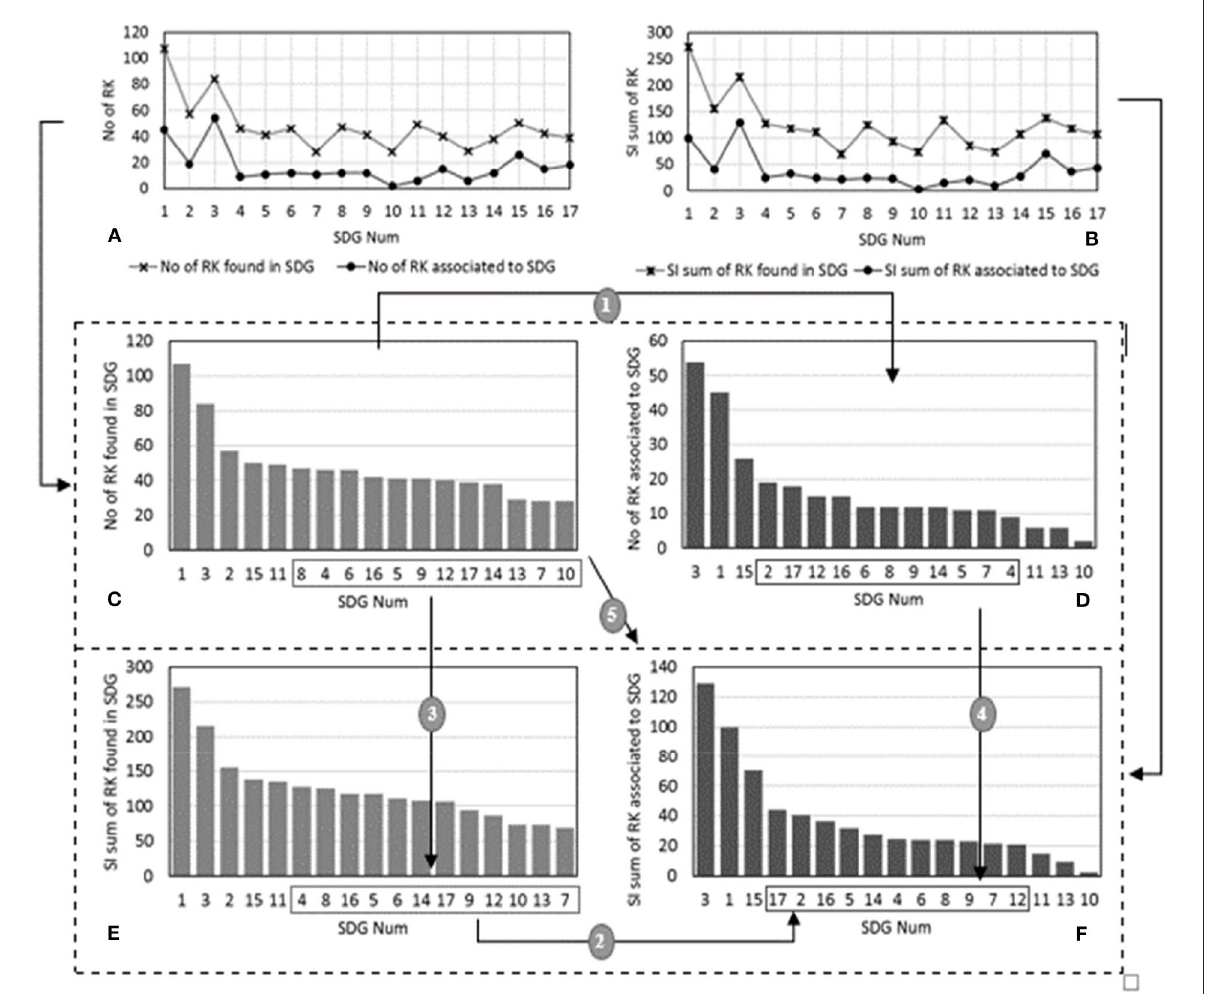
FIGURE4 Sustainability importance of RKs and their association to the SDGs. On (A,B) , results without filtering (prior to using Equation 2) are shown with the cross (x) plots and results with filtering (after applying Equation 2) are shown with the dotted ( • ) plots. On (C,E) , plots are without filtering, whereas on (D,F) plots are with filtering. The transition numbers, (1–5) within bubbles, are those referred in Table 2